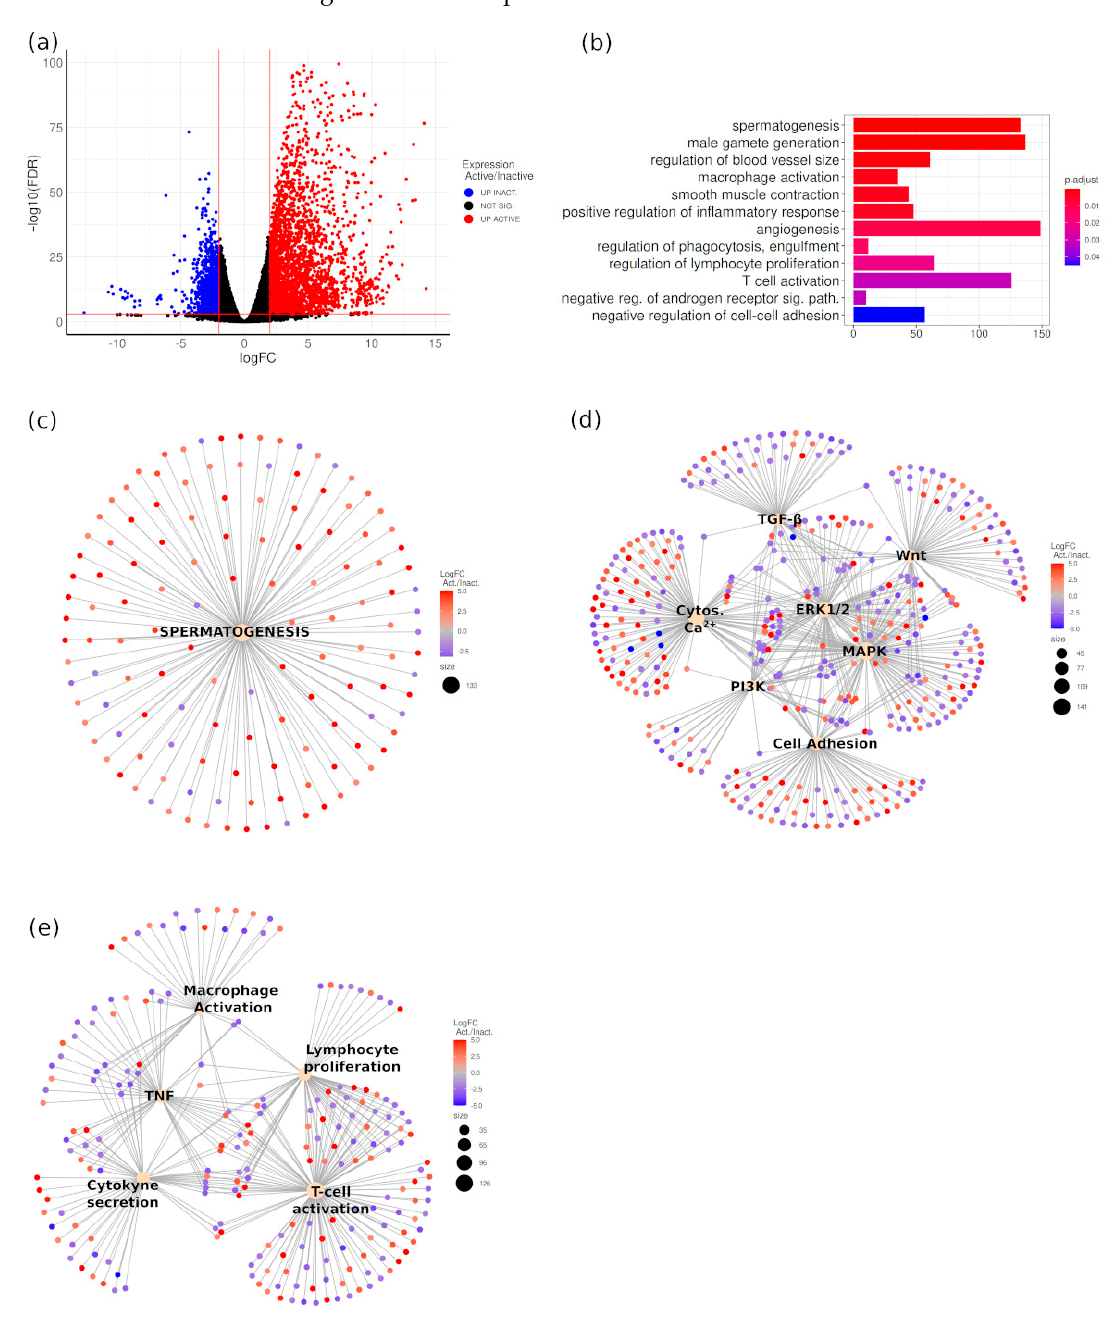
Figure 5. Transcriptomic analysis of active and regressed testes of M. duodecimcostatus . ( a ) Volcano plot of the differential expression test. ( b ) Gene Ontology analysis of the deregulated genes revealed a significant enrichment (p.adjust< 0.05) in terms associated to normal testicular functions. ( c ) Cnetplot of the GO term spermatogenesis. Note that most of the genes are upregulated. The names of the genes are depicted in electronic supplementary material, Figure S1. ( d ) Cnetplot of several significantly enriched GO terms of molecular pathways identified in our Gene Ontology analysis. The names of the genes are depicted in electronic supplementary material, Figure S2. ( e ) Cnetplot of several significantly enriched GO terms associated with the activation of the immune system. The names of the genes are depicted in electronic supplementary material, Figure S4. In pictures ( a , c – e ) red color indicates upregulation in the active testis and blue color upregulation in the regressed testis. In figures ( d , e ), the size of sepia circles is proportional to the number of deregulated genes they